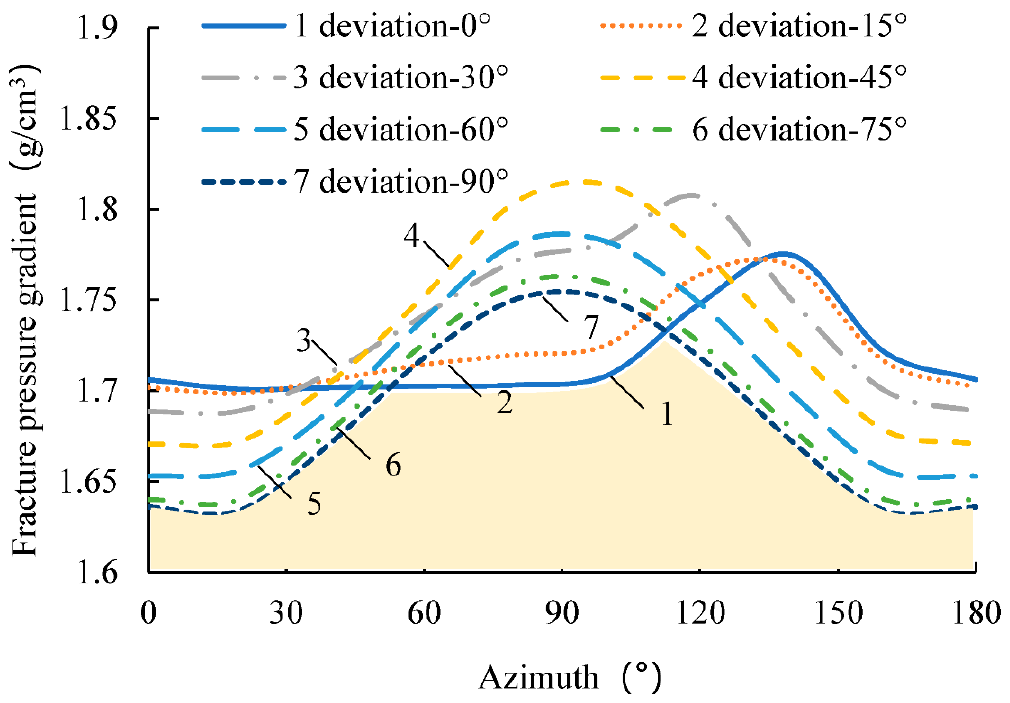
Figure 10. The azimuth and the fracture pressure gradient curves of the wellbore. The cloud diagram of the safe density window is drawn by the lower hemisphere projection method, as shown in Figure 11. The safe density window has a center-symmetric strip distribution in the range of 0.368–0.660 g/cm 3 . The density window of the upper and lower belt regions is narrow, while the density window of the middle region is large. The maximum safe density window is the “crescent” region in the direction of the minimum principal stress. Drilling operations near this zone are most conducive to wellbore stability.